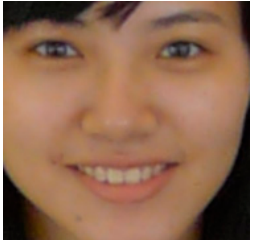
Figure 11. An example photo from the CIA database. Table 16. Recognition results of the CIA photo.